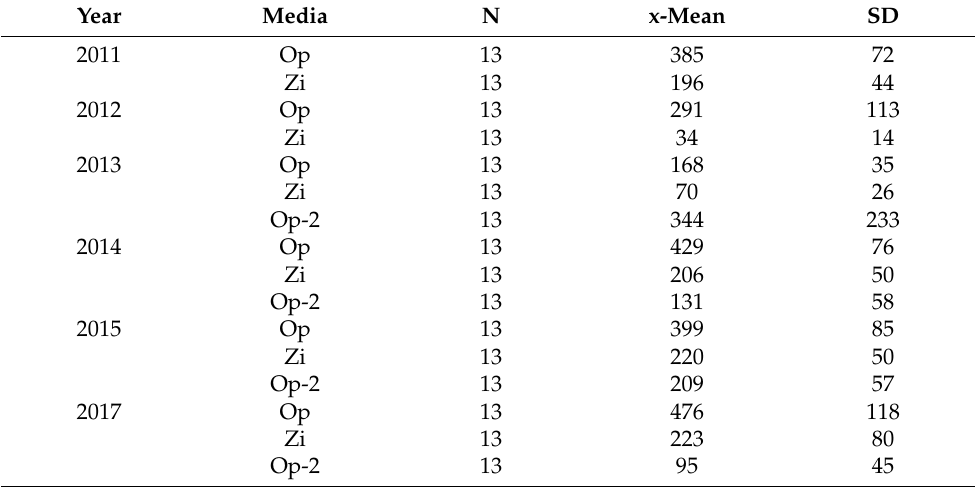
Table 9. Examples of the harvested dry aboveground phytomass in g/m 2 and SD from the 30-cm-depth planter boxes, calculated as dry matter/m 2